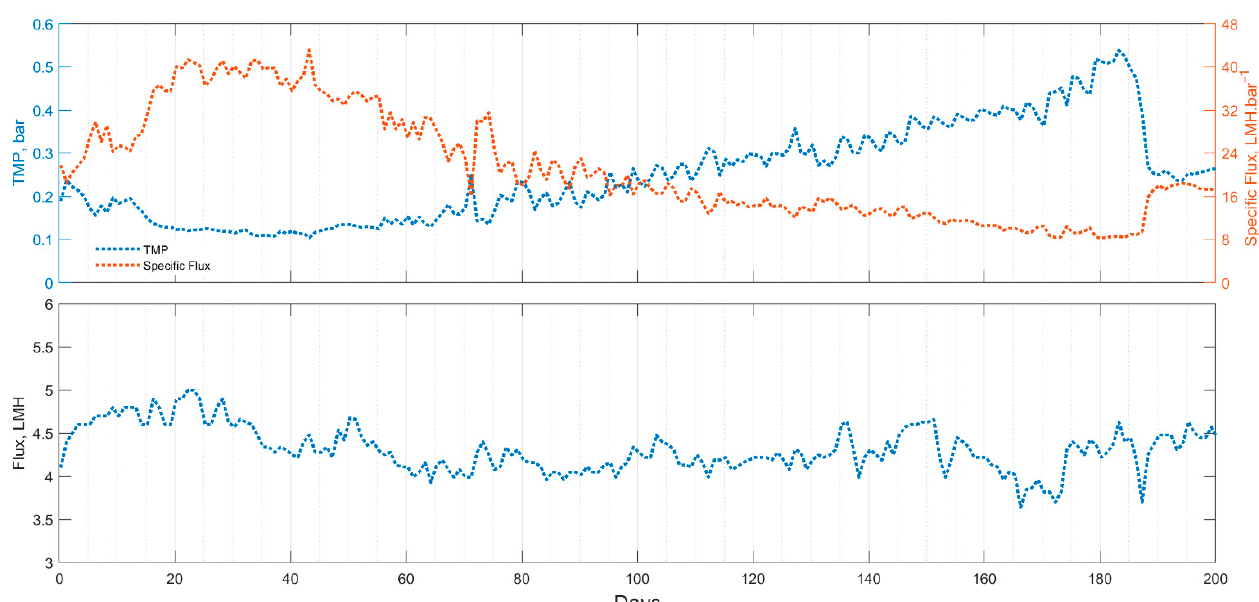
Figure 3. Membrane performance data of the upflow AnMBR: trans membrane pressure (TMP), specific flux; flux.